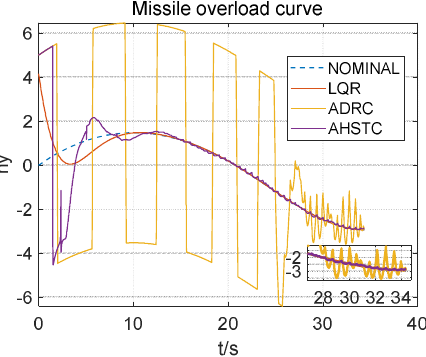
Figure 5. Height y tracking curve.